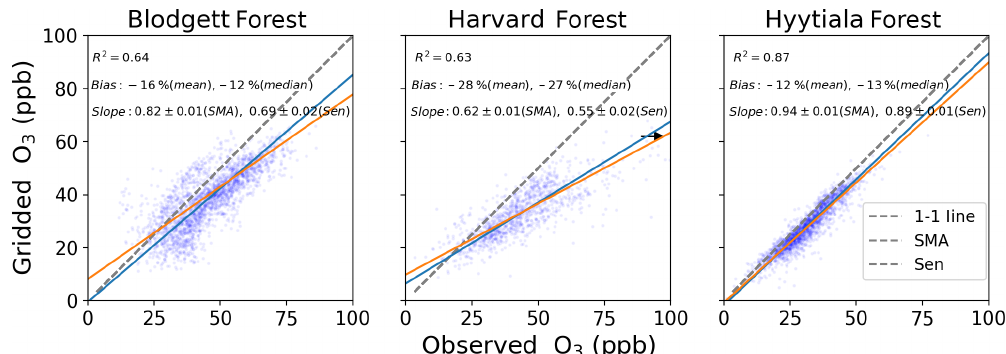
Figure 2. Gridded and observed daily daytime O 3 concentrations at Blodgett, Harvard, and Hyytiälä forests. Inset numbers provide the coefficient of determination ( R 2 ), mean and median bias, the standard major axis (SMA) slope, the Thiel–Sen (Sen) slope, and the 68% confidence interval of the slopes. The black arrow points towards outliers that are not